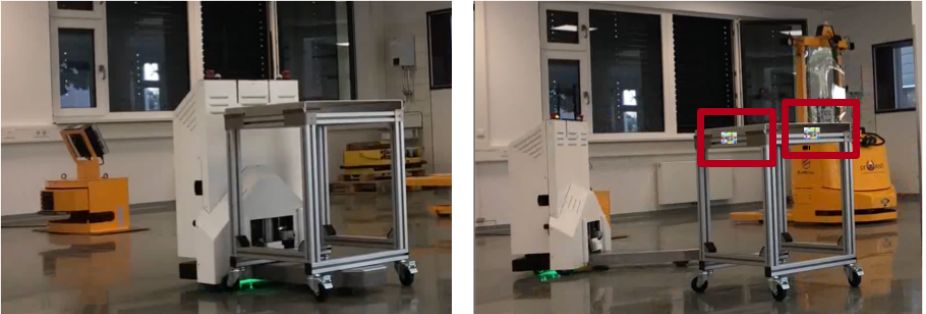
Figure 1. An example of an adversarial attack. On the left, the normal situation is shown. On the right figure, one object has adversarial patch(es), which results in the anomaly. More specifically, the AGV cannot detect the object